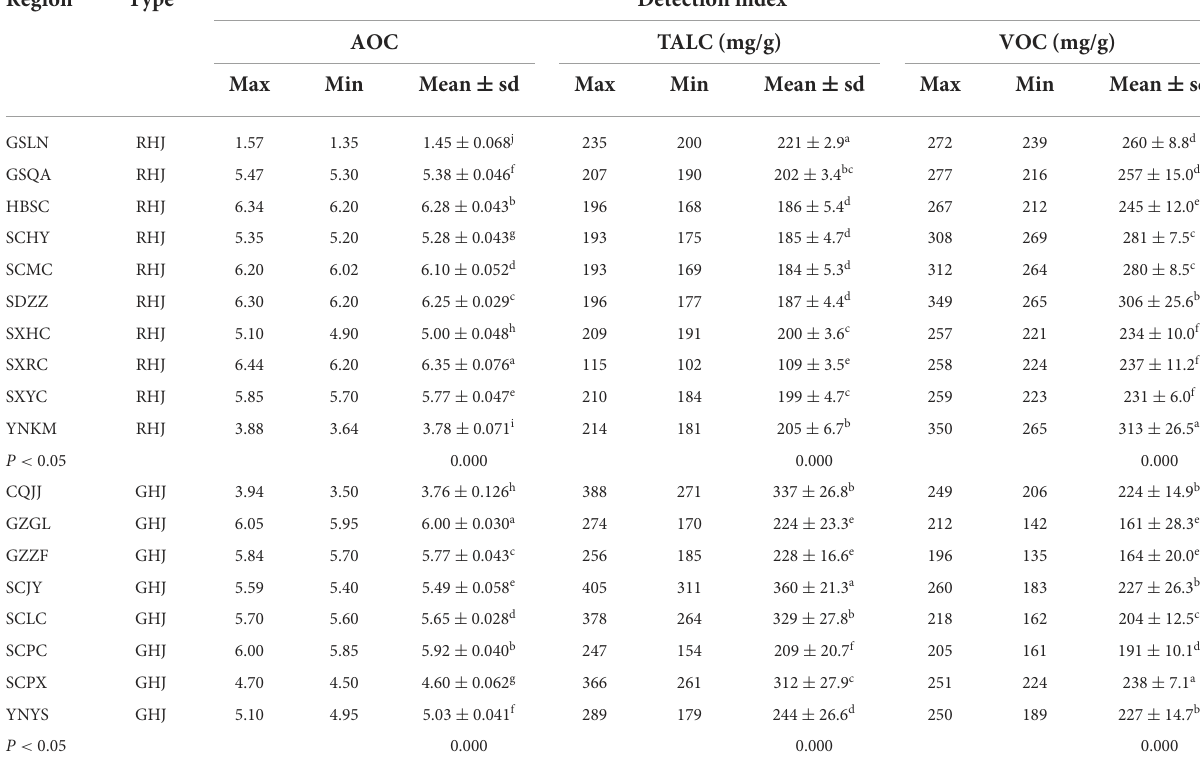
TABLE 1 Differences of chemical indicators of HJ from different regions.